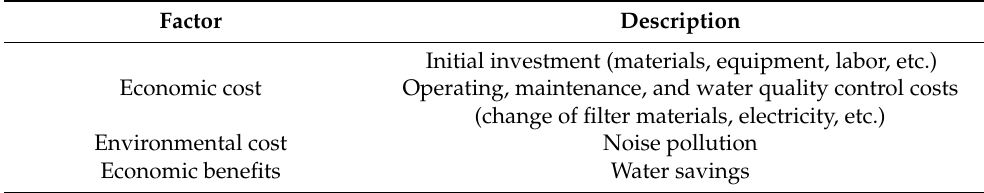
Table 2. Factors considered for quantitative economic